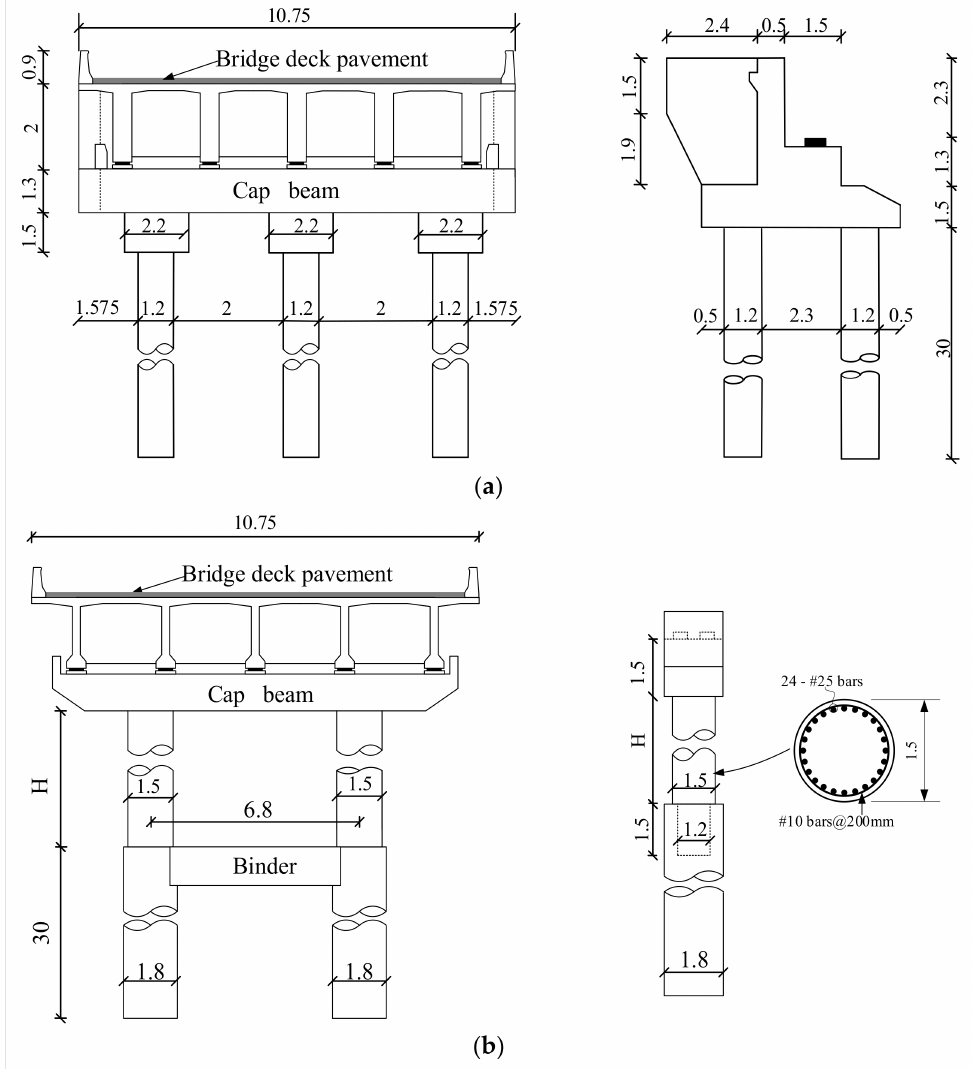
Figure 1. Bridge prototype (unit: m): ( a ) abutment layout; ( b ) pier